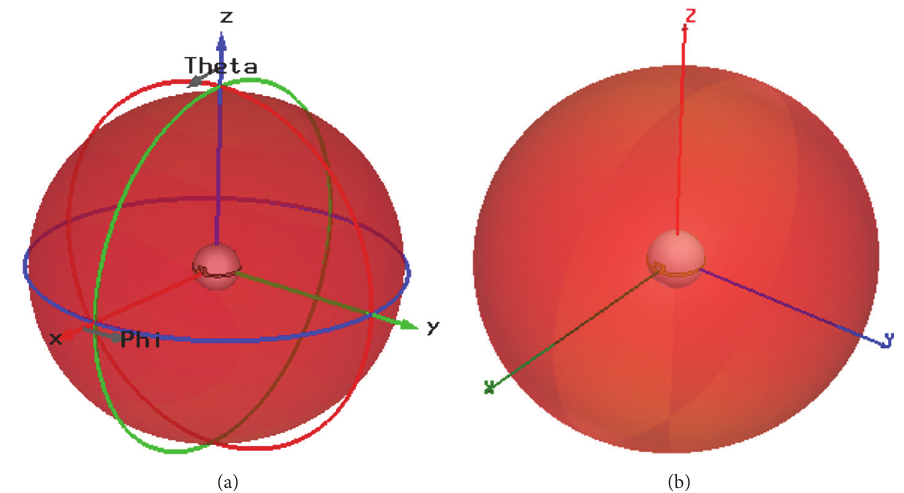
Figure 21: Radiation patterns ( 𝐸 total ) in 3D of the 3D spherical antenna (Table 7): (a) CST and (b)